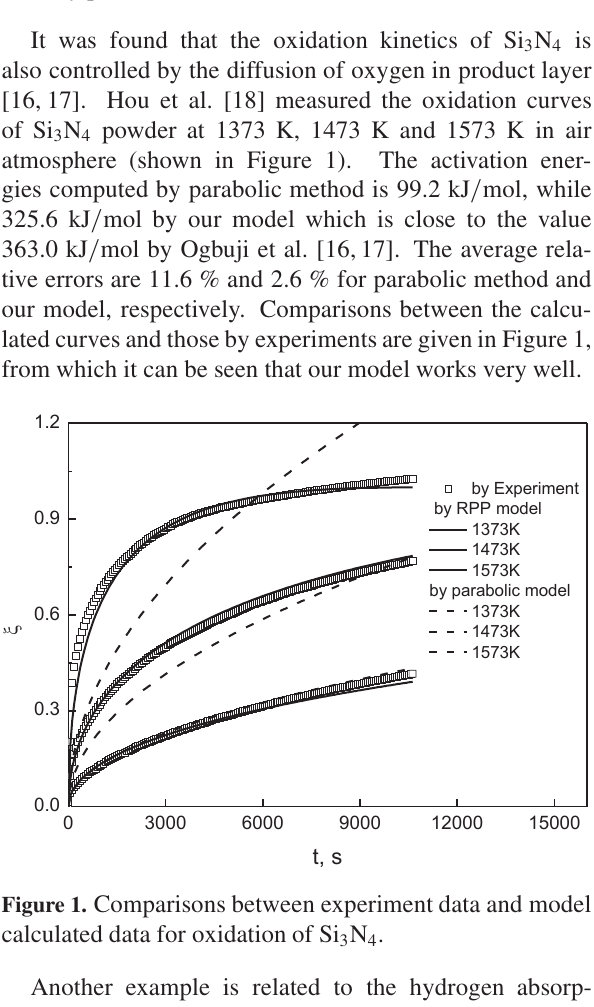
Table 1. Comparison of the average relative error calcu- lated by parabolic model and Chou model.